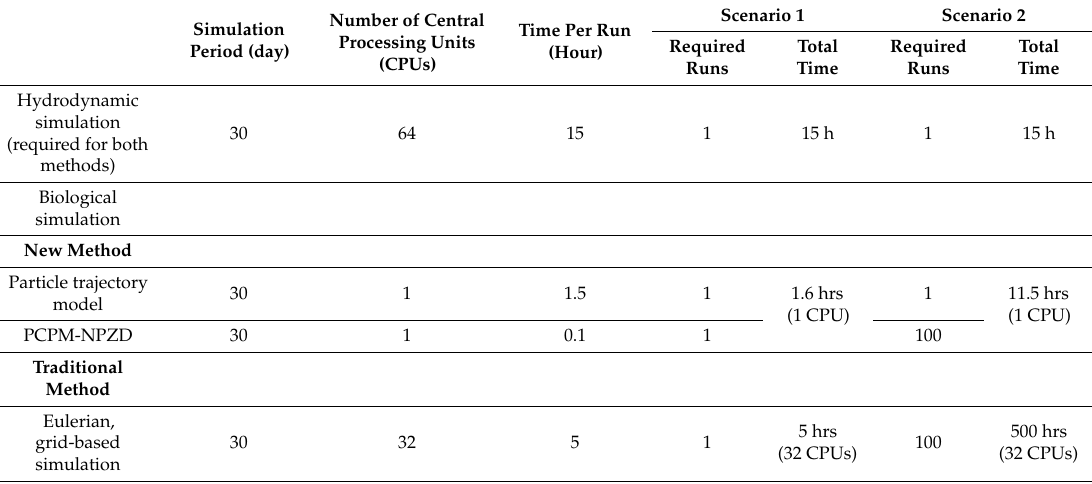
Table 2. The comparison of total run time using the method developed in this study (new method) and the grid-based Eulerian method (traditional method) in two scenarios. Scenario 1: conduct coupled biophysical model only once; Scenario 2: run ensemble simulation of the coupled biophysical model for 100 simulations with different biological